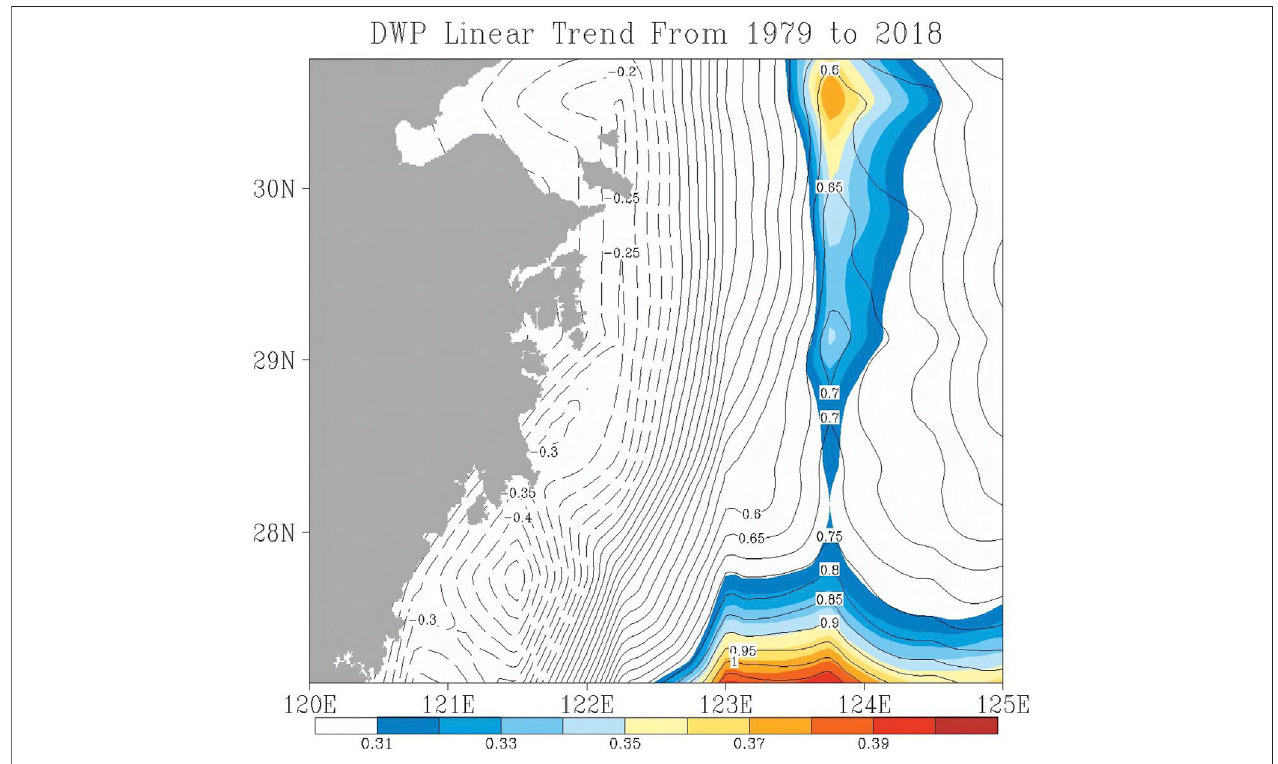
FIGURE 9 | Interannual trend of wind power density (the contour line is the tendency value, the shaded part is the area put through the signi fi cance test).